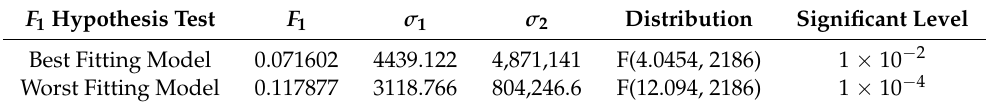
Table A4. F 1 Hypothesis Testing.